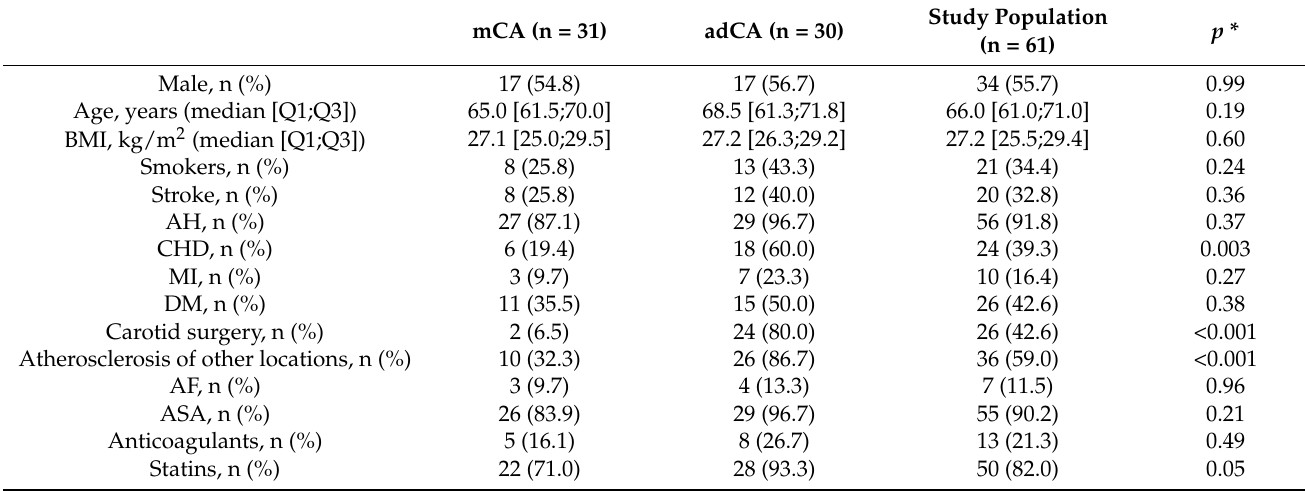
Table 1. Clinical and demographic characteristics of the study population.